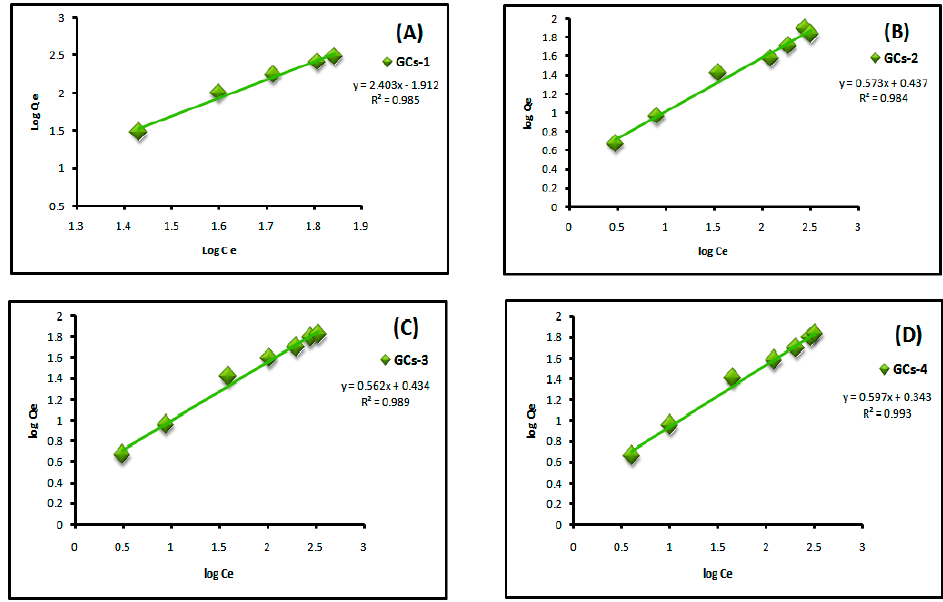
Figure 9. Freundlich plot for Ni(II) adsorption on to ( A ) GCs-1; ( B ) GCs-2; ( C ) GCs-3 and ( D ) GCs-4.